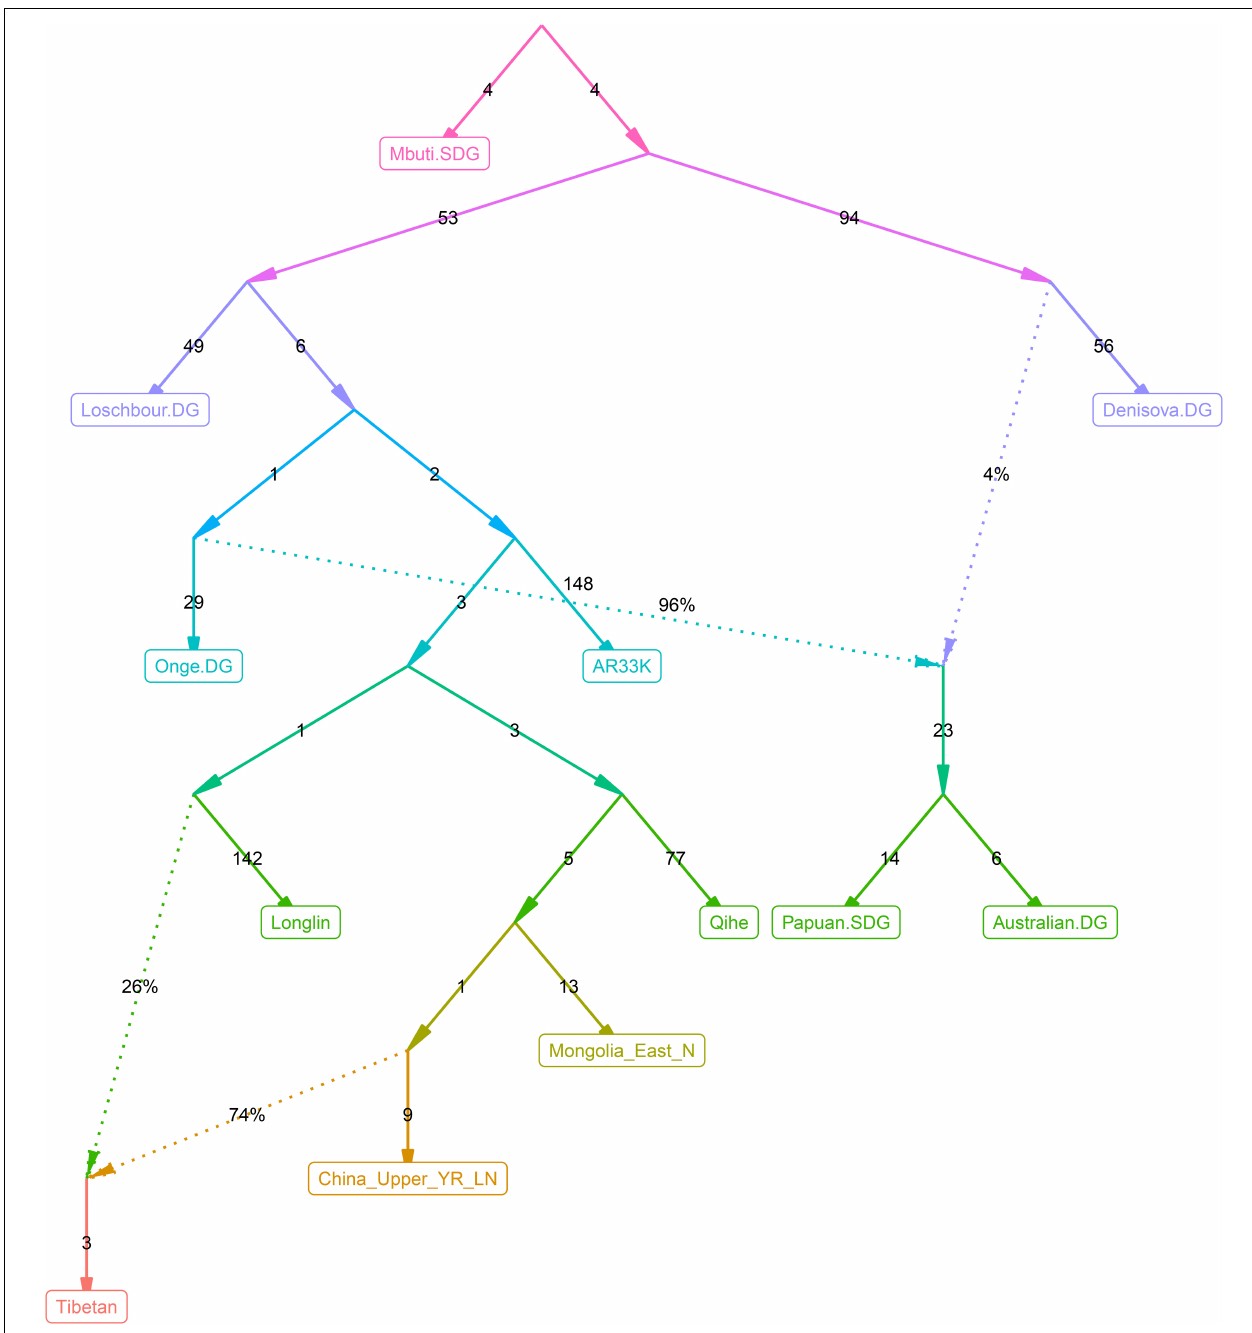
FIGURE 10 | qpGraph-based admixture models showed the differentiated Denisovan admixture landscape between East Asians and